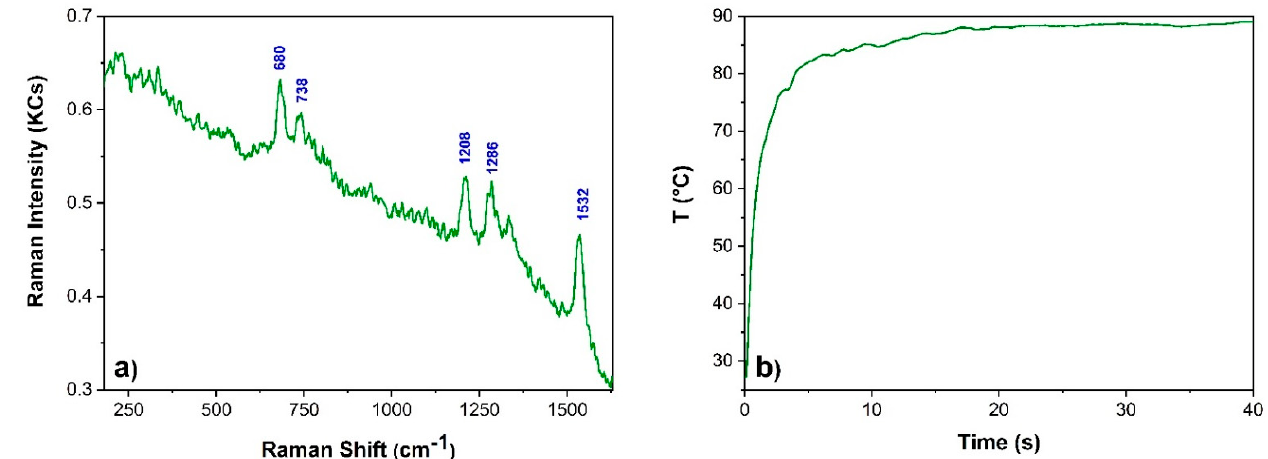
Figure 11. ( a ) Figure shows phthalocyanine Raman spectrum collected from the site C using 22 mW; ( b ) Temperature profile based on a measured emissivity of 0.92.